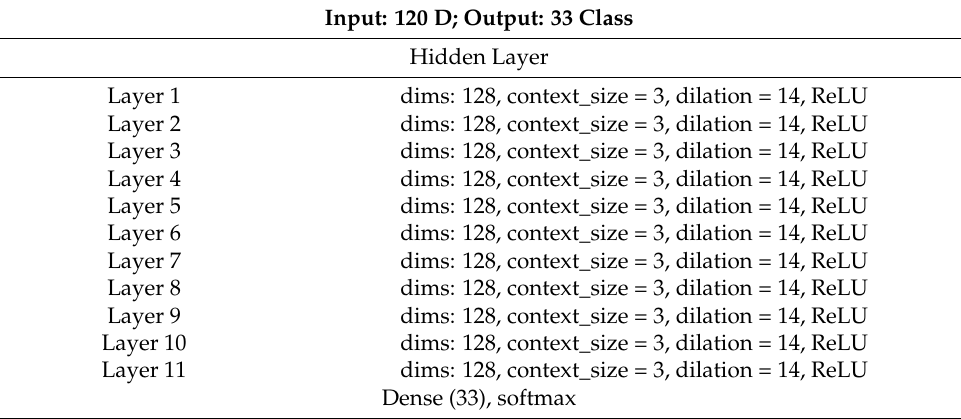
Table A4. Structure of the Time Delay Neural Network (TDNN) applied in ASR-based